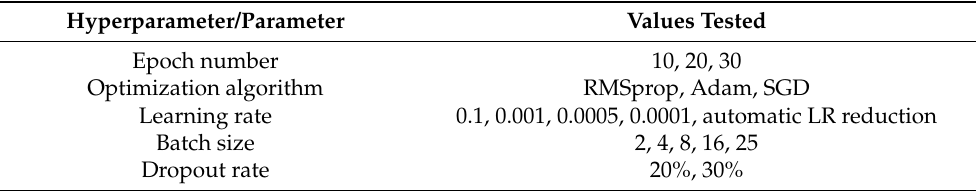
Table 4. Different parameter and hyperparameter value scenarios that were tested during the training of the selected models.